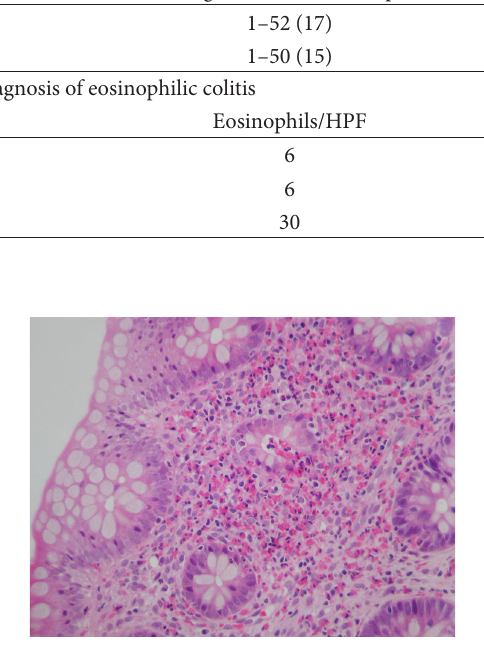
F 1: A heavy colonic eosinophilic in�ltrate of phils/HPF with eosinophilic cryptitis and microabscess